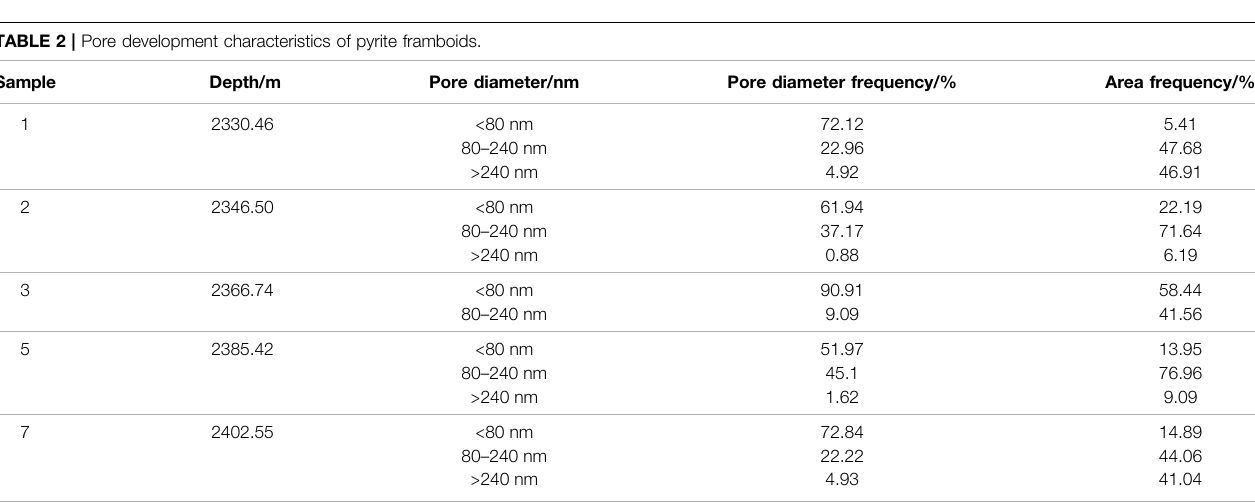
TABLE 2 | Pore development characteristics of pyrite framboids.